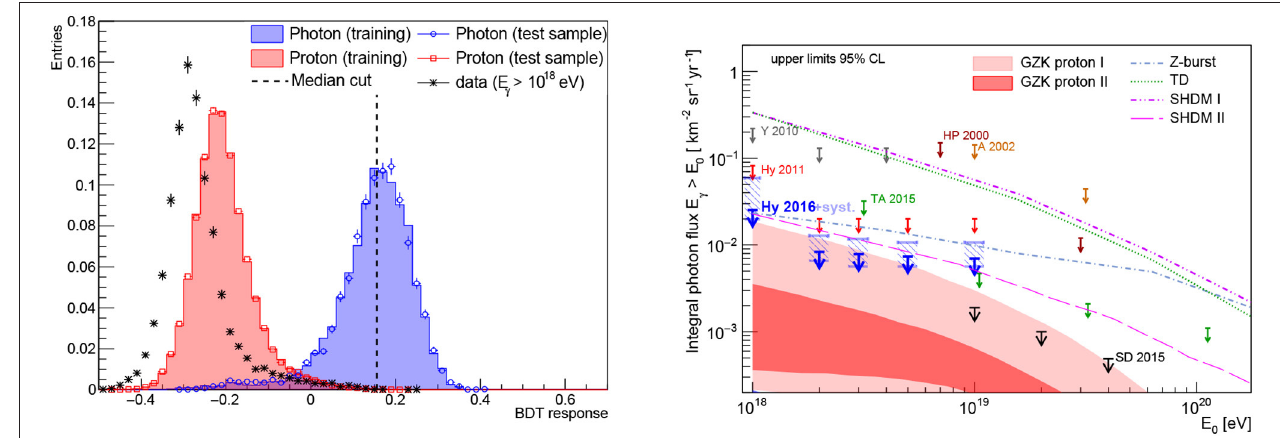
FIGURE 5 | (Left) Photon identification with a Boosted Decision Tree for signal (photon, blue), background (proton, red) and data (black). For simulations, both the training and the test samples are shown. The cut at the median of the photon distribution is indicated by the dashed line. QGSJET-II-04 is used as high-energy hadronic interaction model. (Right) Compilation of upper limits on the integral photon fluxes from Aab et al. (2017e). Blue arrows: Integral photon upper limits from the 9 year hybrid data sample assuming a photon flux following E − 2 and with no background subtraction. The limits obtained when the detector systematic uncertainties are taken into account are shown as horizontal segments (light blue) delimiting a dashed-filled box at each energy threshold; Black arrows: Nine year SD data sample (Bleve, 2016). Previous data from Auger as well as data from TA, AGASA, Yakutsk, and Haverah Park are included for comparison. The lines and shaded regions give the predictions for top-down models and GZK photon fluxes, respectively, assuming different parameters (references can be found in Aab et al., 2017e).